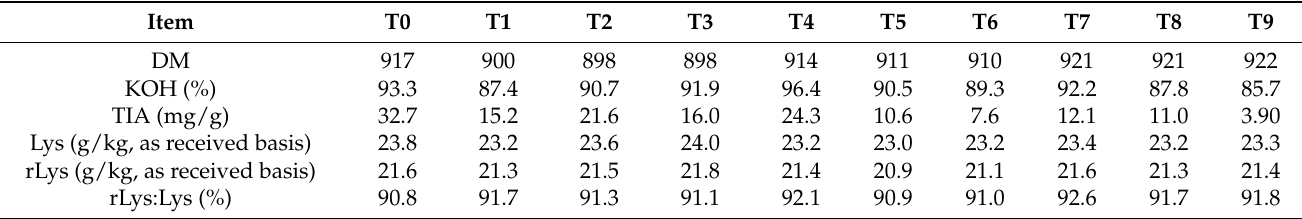
Table 4. Effect of heat treatments on the in vitro protein quality indicators of full-fat soybeans.